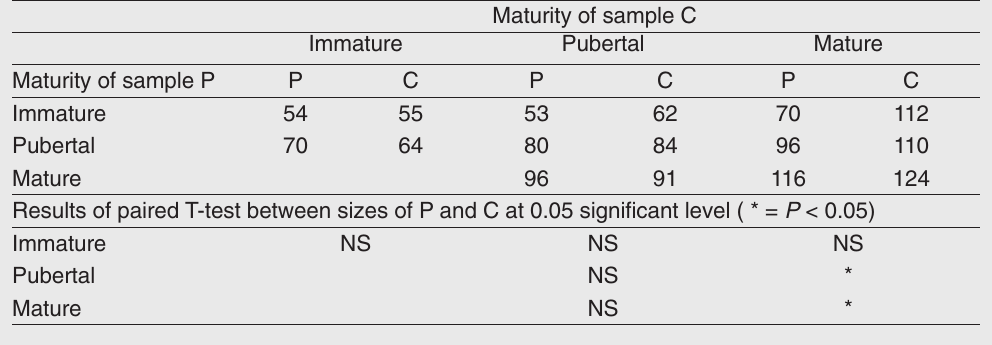
Table 3. Average seminiferous tubule diameter (µm) in peripheral (P) and central (C) testis tissue samples, grouped by histological maturity assessment of P and C samples and results